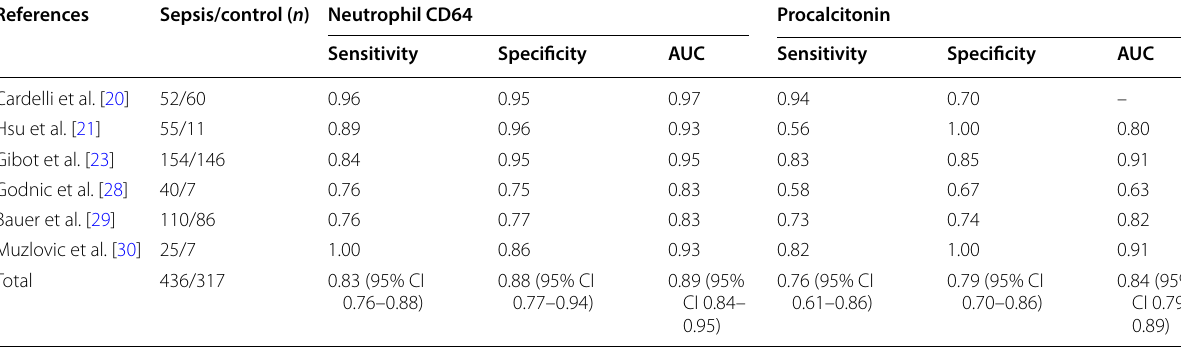
AUC area under the receiver operating characteristic curve,